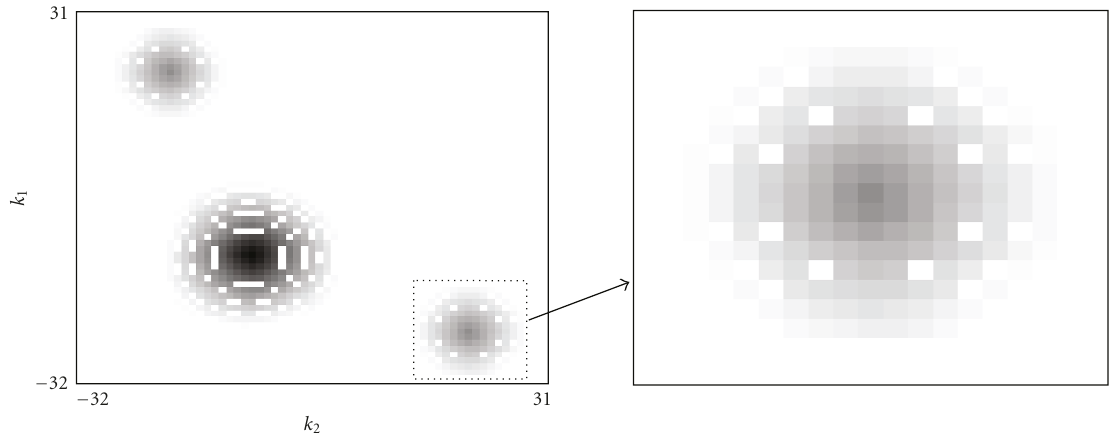
Figure 9: Illustration of the number of CLKs taken by the proposed design in corresponding frequency-frequency points during the execution. Di ff erent numbers of CLKs are illustrated by gray-scale shaded points, where the white ones denote minimal number of 2 CLKs, + 3 L m + 2 = 67 whereas the black ones denote maximum number of 2 L 2 m